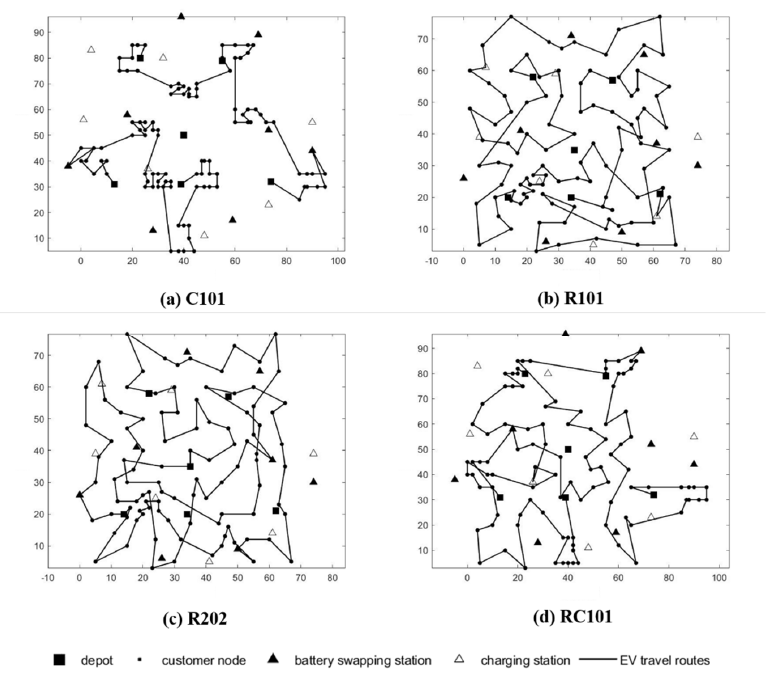
Fig. 3. The planning schemes of HOTDMDEVRPBRS in different